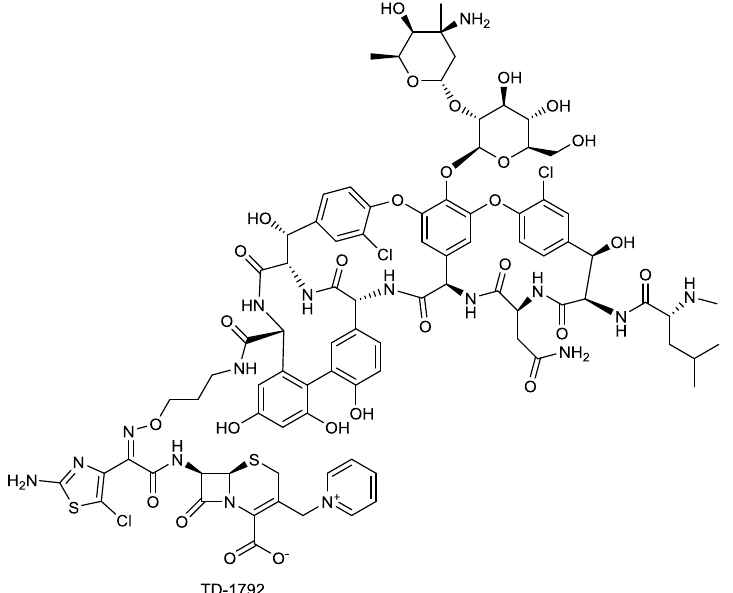
Figure 10. Chemical structure of TD-1792